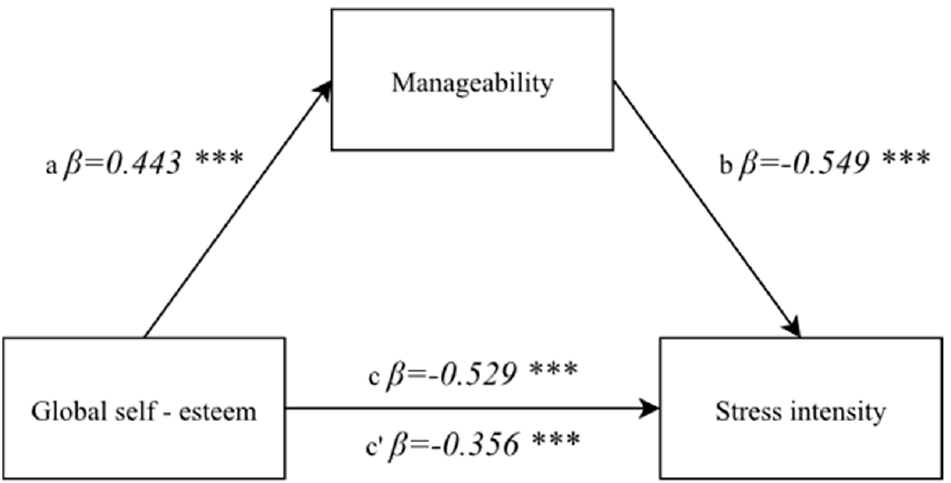
Figure 4. A model of the mediatory role of a sense of manageability between global self-esteem and the stress intensity. Statistically significant: *** p <